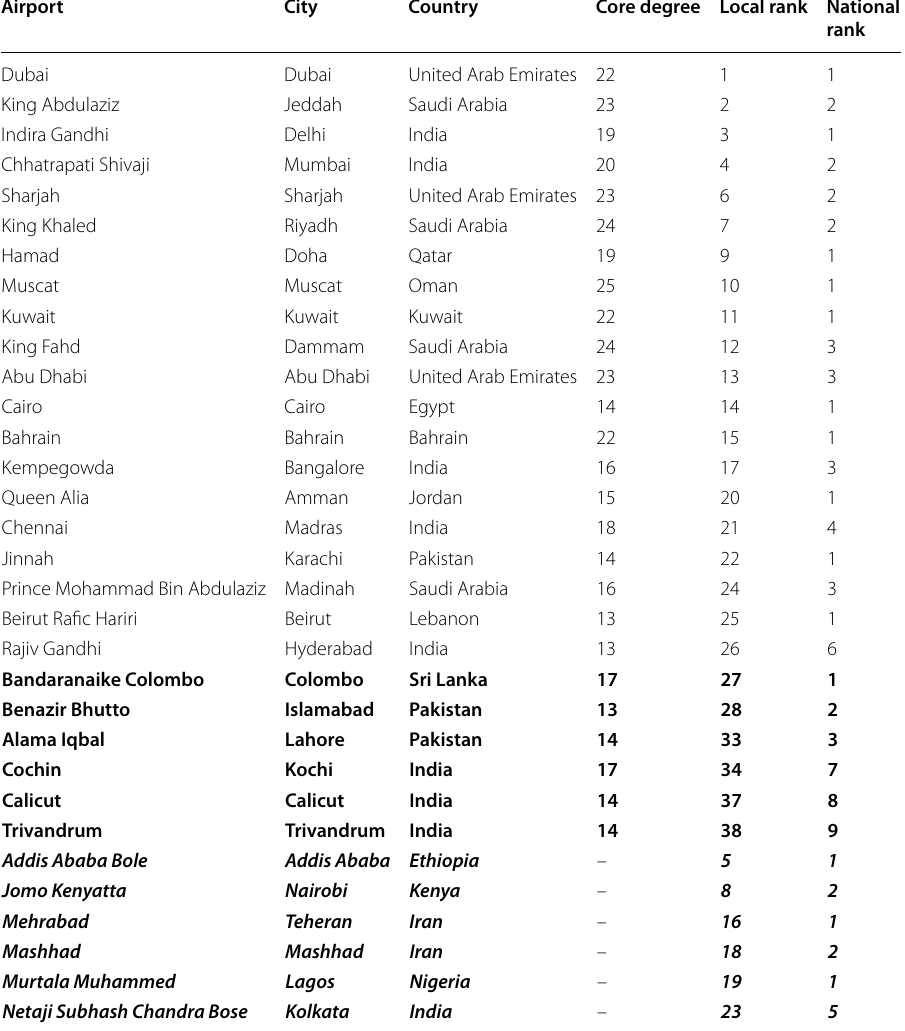
Airports not in the top 26 regional hubs are in bold. The core degree of a node is its number of links in the maximum k-core. Local rank is the rank in the large local component. National rank is the airport rank in its country. Airports in the top 26 regional hubs and not in the k-core are in bolditalic